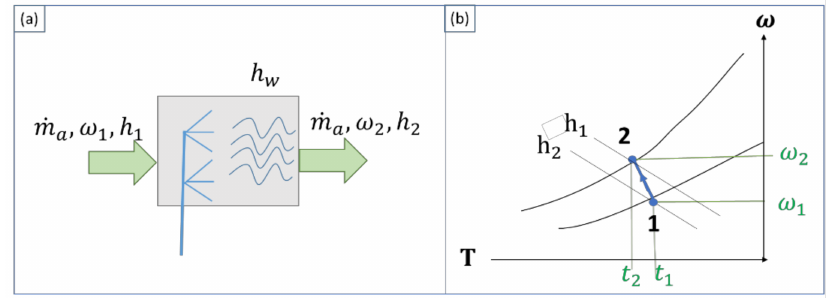
Figure 9. ( a ) Humidification and cooling and ( b ) psychometric diagram of the